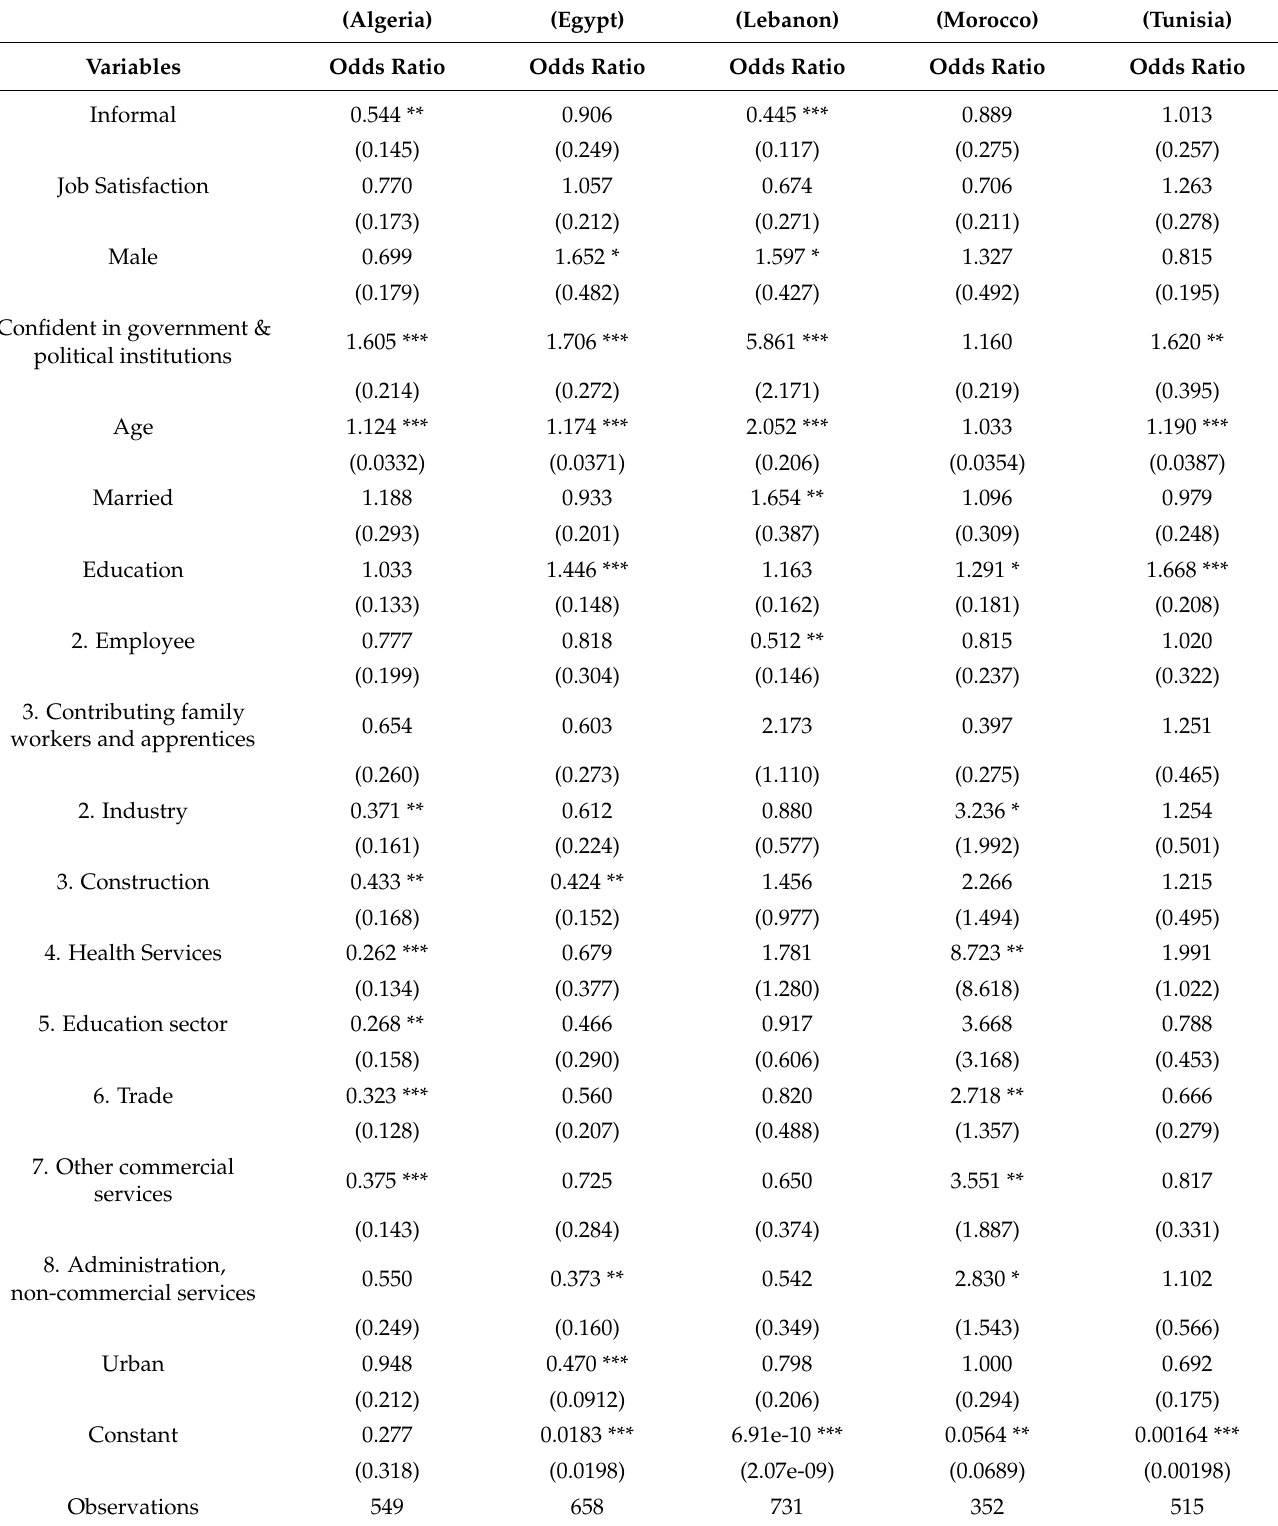
Table A6. Logistic regression on the “vote turnout” index by